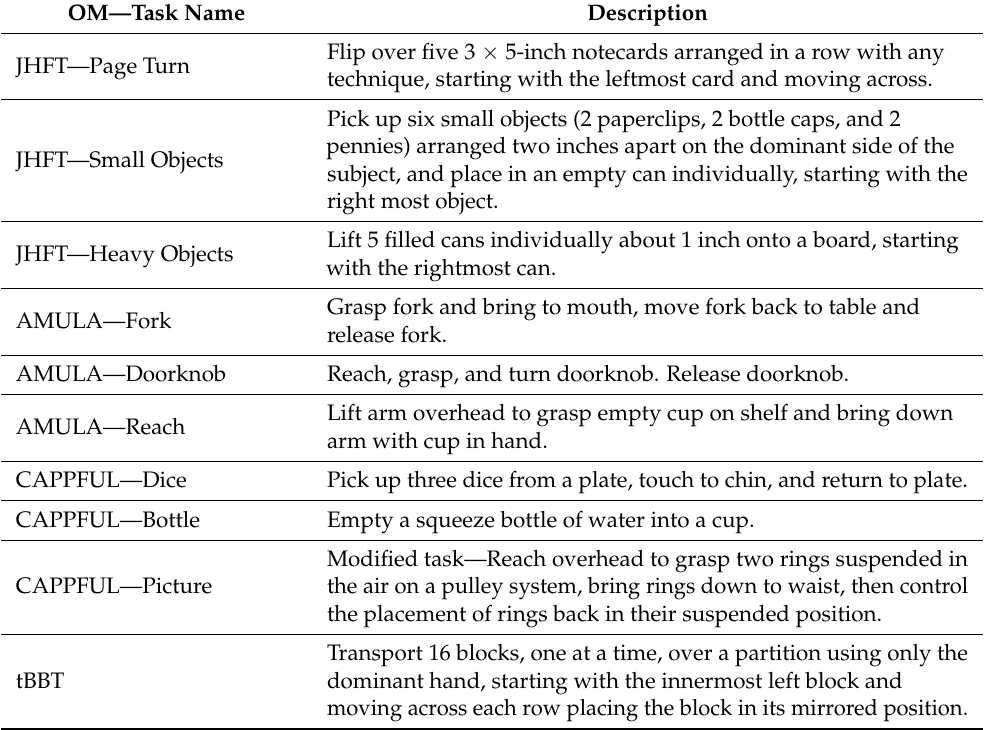
Table 1. Description of tBBT and tasks from the JHFT, AMULA, and CAPPFUL performed by study